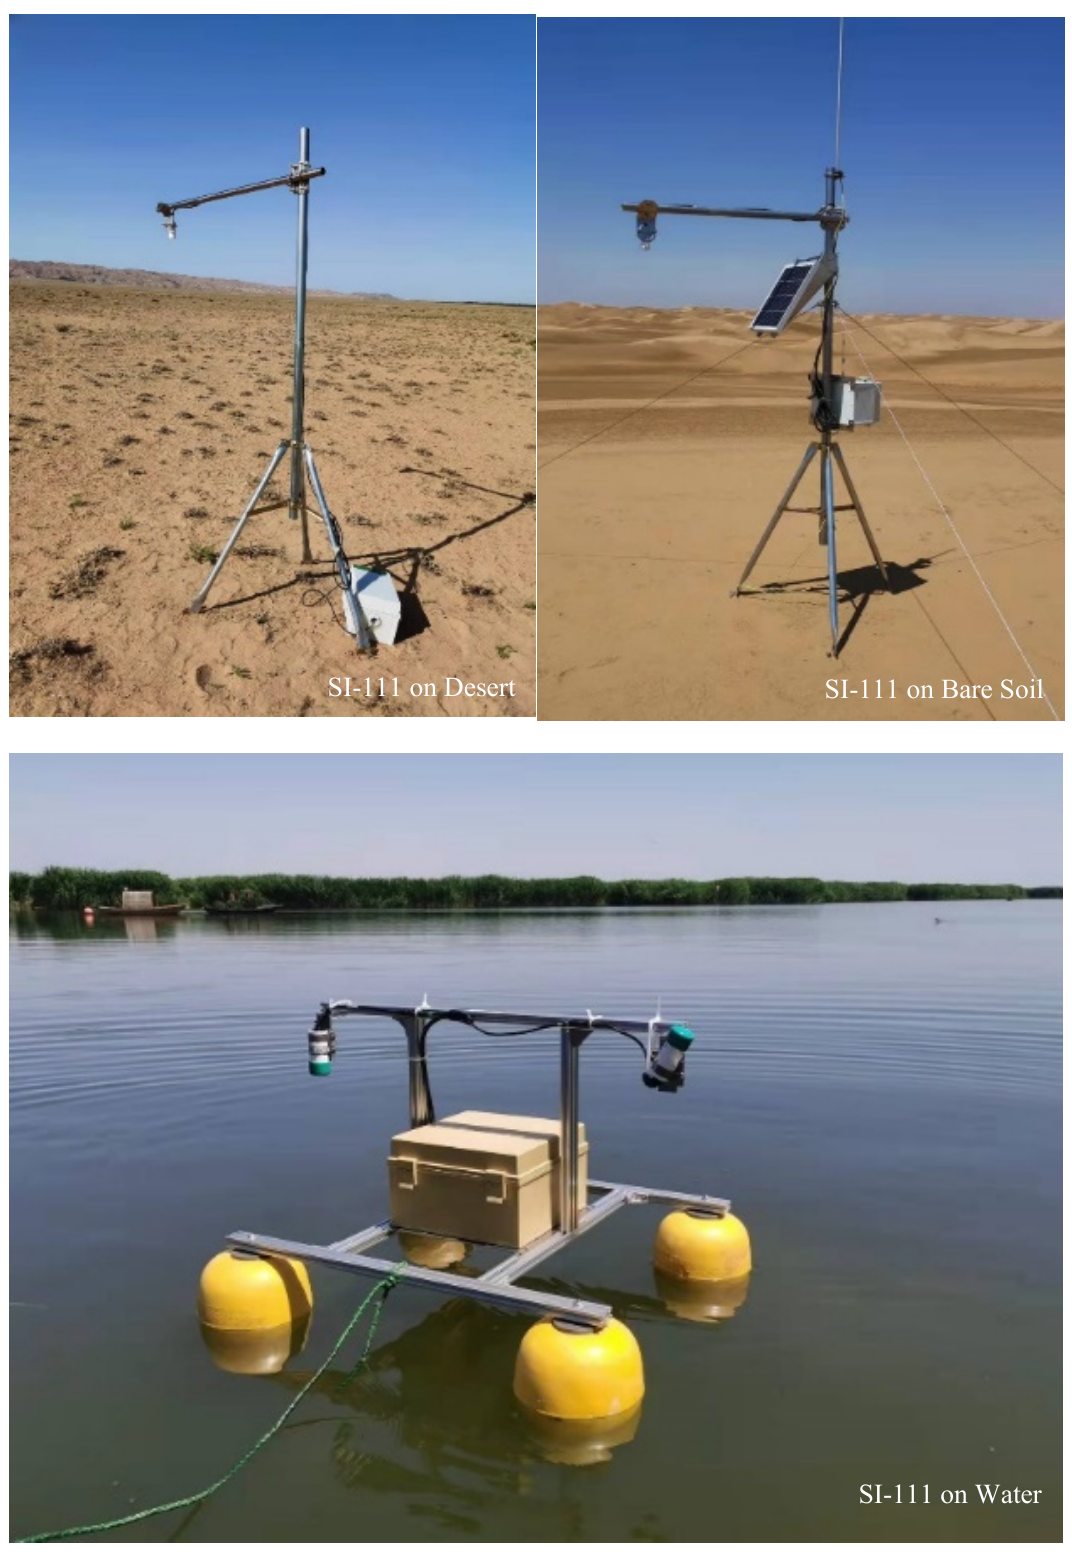
Figure 7. Experimental deployment of the SI-111 infrared temperature sensor.